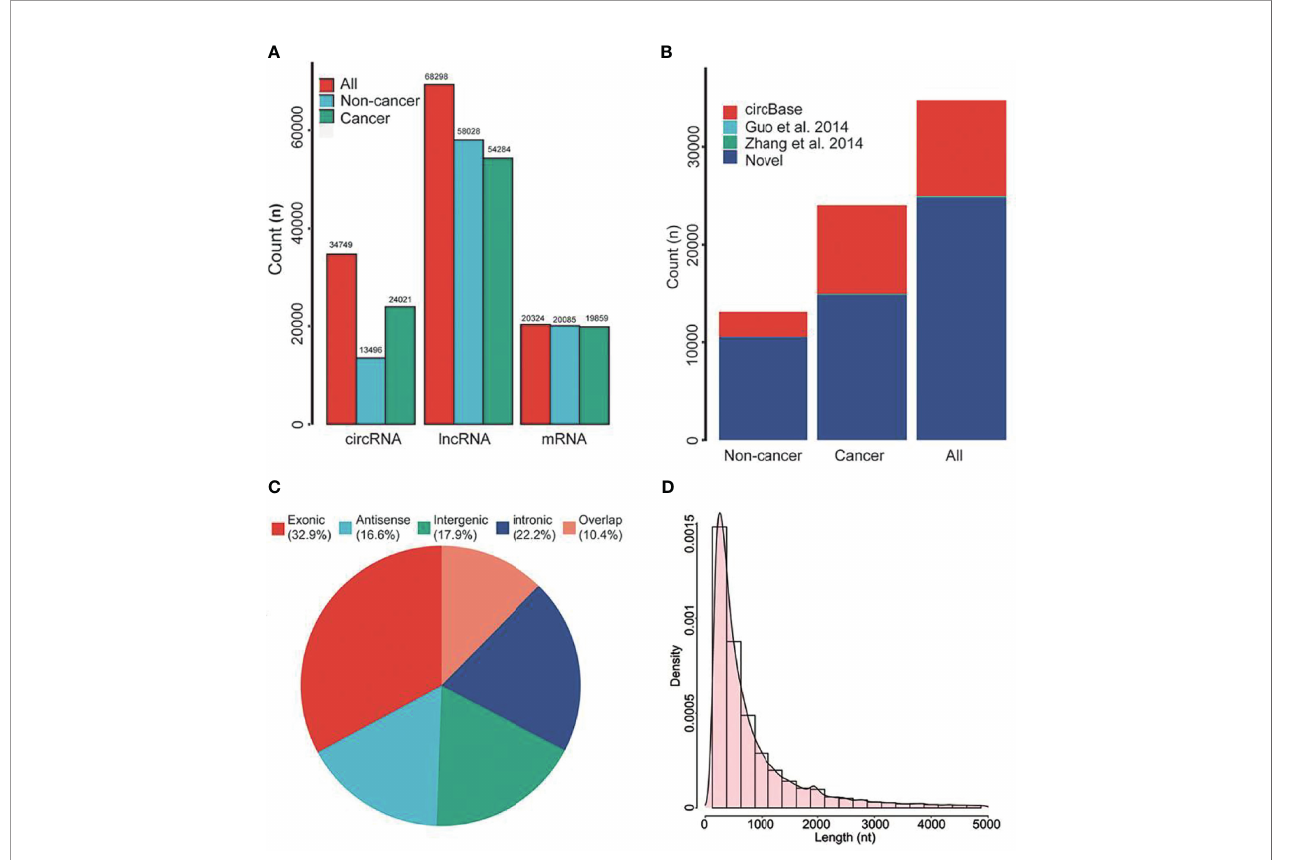
FIGURE 2 | RNA composition in EVs. (A) The types of RNAs in EVs. (B) Annotation of circRNAs. (C) Source of circRNAs. (D) Length distribution of circRNAs. nt, Nucleotide. All, all of individuals. Overlap, sense overlapping